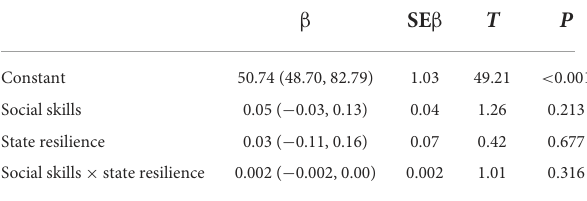
TABLE 2 Correlation between resilience, social skills and recovery ( N = 100).